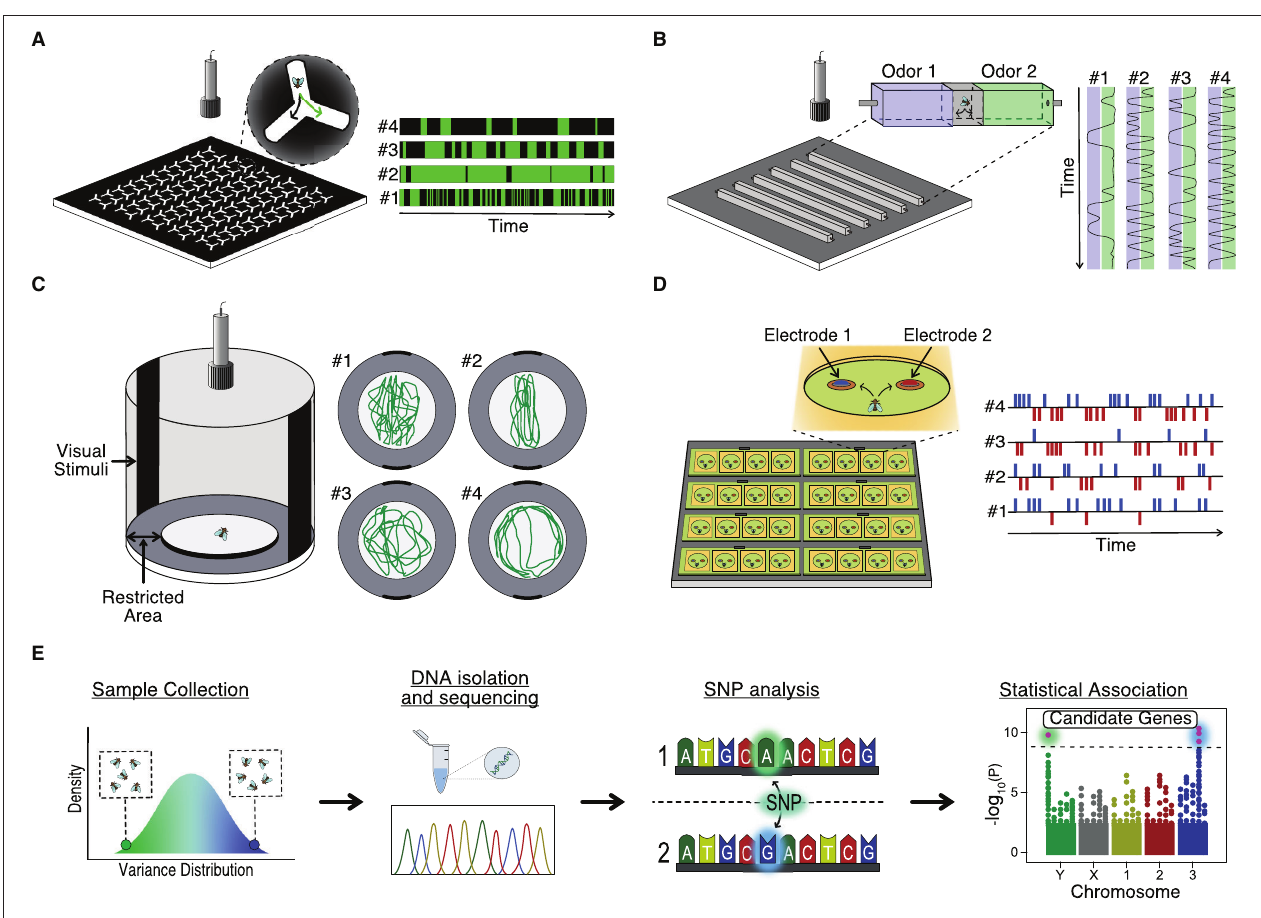
FIGURE 2 | High throughput analysis of behavior variance. (A) Schematic set up for study locomotor handedness variability by Y-maze (Ayroles et al., 2015; Buchanan et al., 2015 ). (B) Schematic setup for study olfactory guidance variability. Adapted from Honegger et al. (2019). (C) Schematic Buridian arena to study visual orientation variability (Colomb et al., 2012). (D) Schematic FlyPAD set-up to study feeding microstructure variability (Itskov et al., 2014). (E) Genome-Wide Association Studies (GWAS)